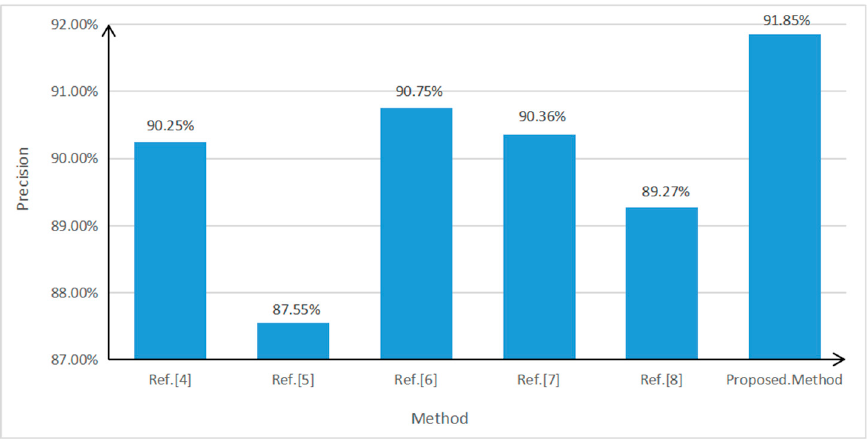
Figure 11. Precision values of various front-vehicle detection methods.